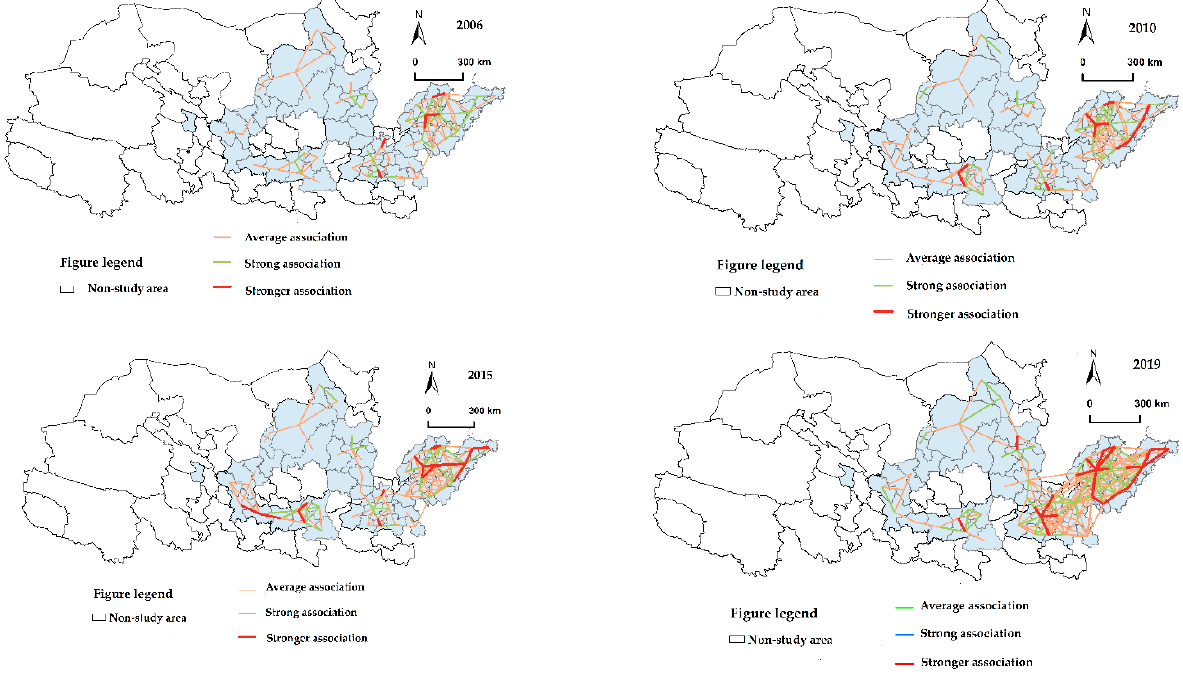
Figure 6. Spatial distribution pattern of carbon emission efficiency in the Yellow River Basin.